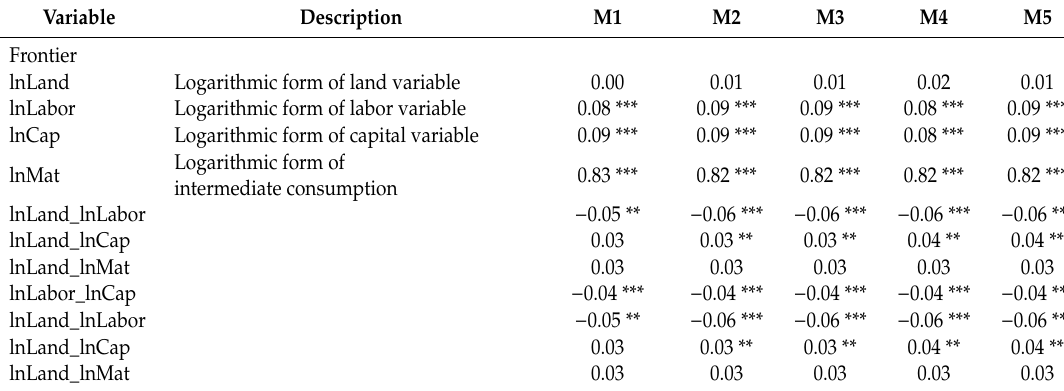
Table 2. Estimation